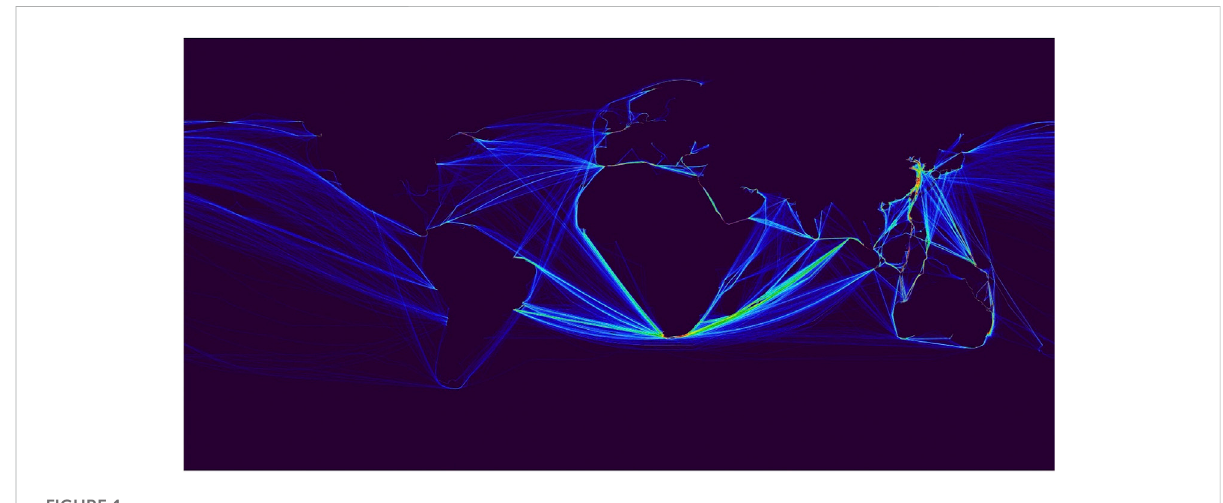
FIGURE 1 AIS trajectories of 7,849 bulk carriers in